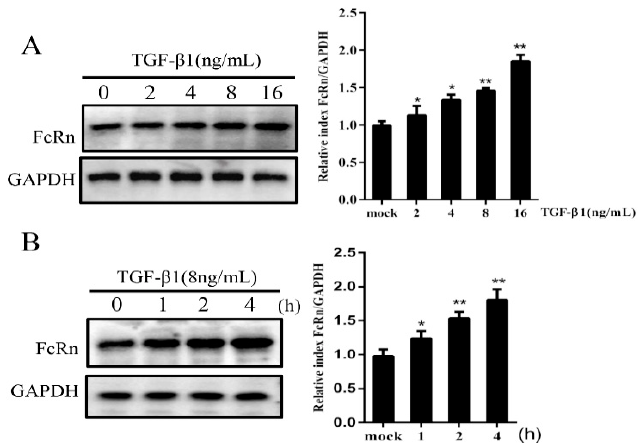
Figure 1. TGF- β 1 upregulates pFcRn expression in a dose- and time-dependent manner. ( A ) IPEC-J2 cells were stimulated with TGF- β 1 at the indicated dosages (0, 2, 4, 8 and 16 ng/mL) and pFcRn ex- pression was analysed by Western blotting. ( B ) IPEC-J2 cells were incubated with TGF- β 1 (8 ng/mL) and collected at 1, 2 and 4 h, followed by the Western blot analysis of pFcRn expression. The right panel represents protein band quantification determined by densitometry and normalized to GAPDH; * p < 0.05, ** p <